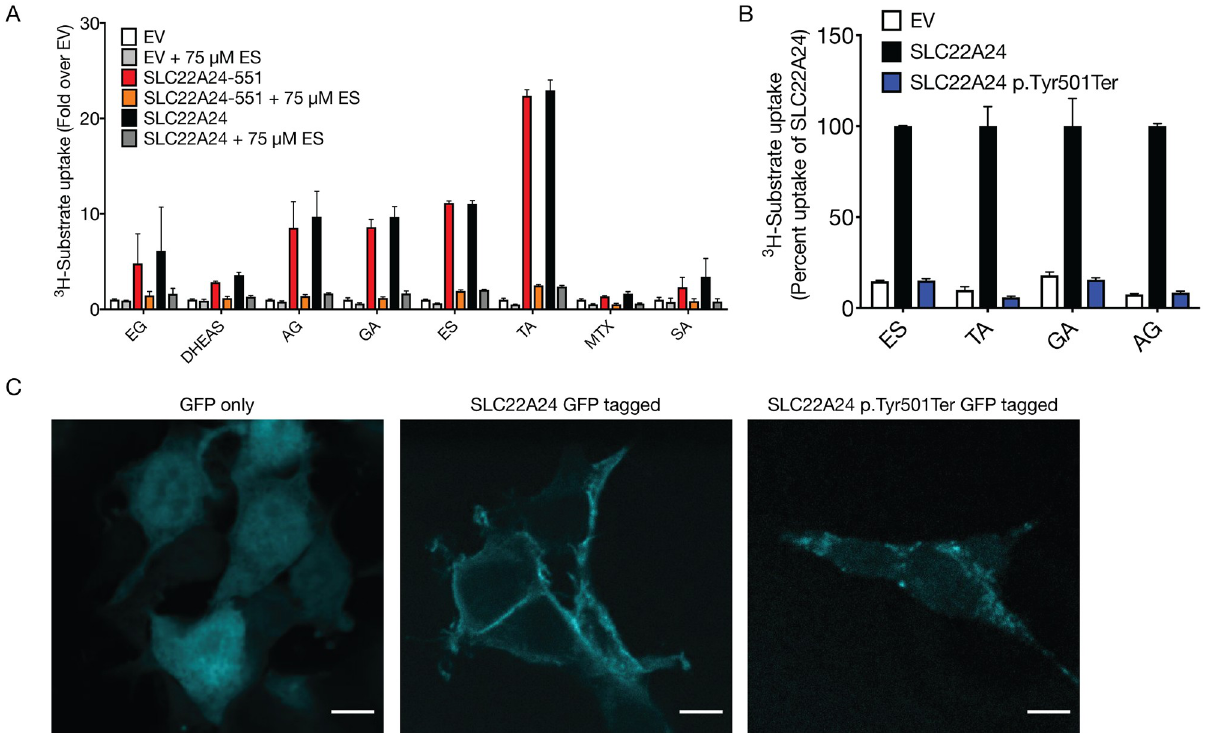
Fig 6. Uptake of various anions by two SLC22A24 isoforms and the effect of a common nonsense variant, p.Tyr501Ter on uptake and plasma membrane localization. (A) Fold uptake over empty vector for different substrates. HEK293 Flp-In cells were transiently transfected with different constructs containing SLC22A24 or SLC22A24-551 . The experiments were repeated at least one time. Data represents means ± S.D. of two independent experiments. Underlying data are provided in S1 Data. (B) Transport activity for different substrates was compared in HEK293 Flp-In cells transiently transfected with SLC22A24 or SLC22A24 p.Tyr501Ter. The uptake of SLC22A24-expressing cells was set to 100%. Underlying data are provided in S1 Data. Data represents means ± S.D. from three wells. The experiments were repeated one time and similar results were obtained. (C)